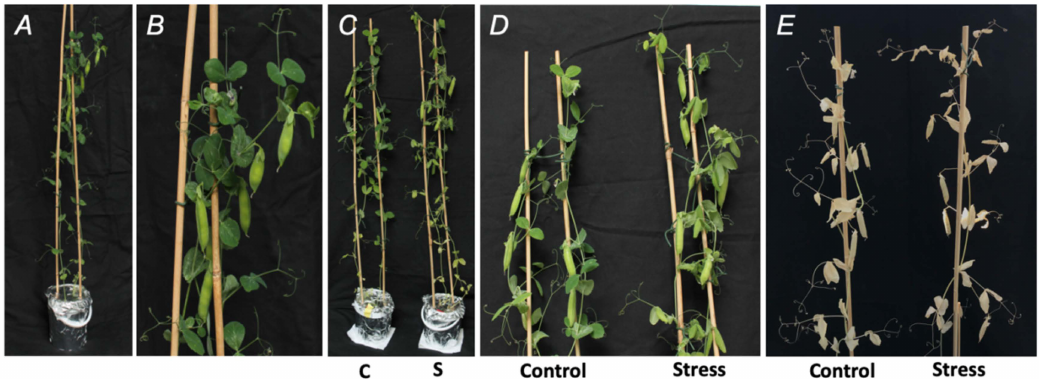
Figure 2. Pea ( Pisum sativum L., cultivar SGE) plants before stress application ( A , B ), after a two-day exposure to the aqueous medium with and without supplementation of 2.5% ( w / v ) PEG 8000 (defined as Stress and Control, respectively, C , D ), and after the completeness of seed maturation ( E ).